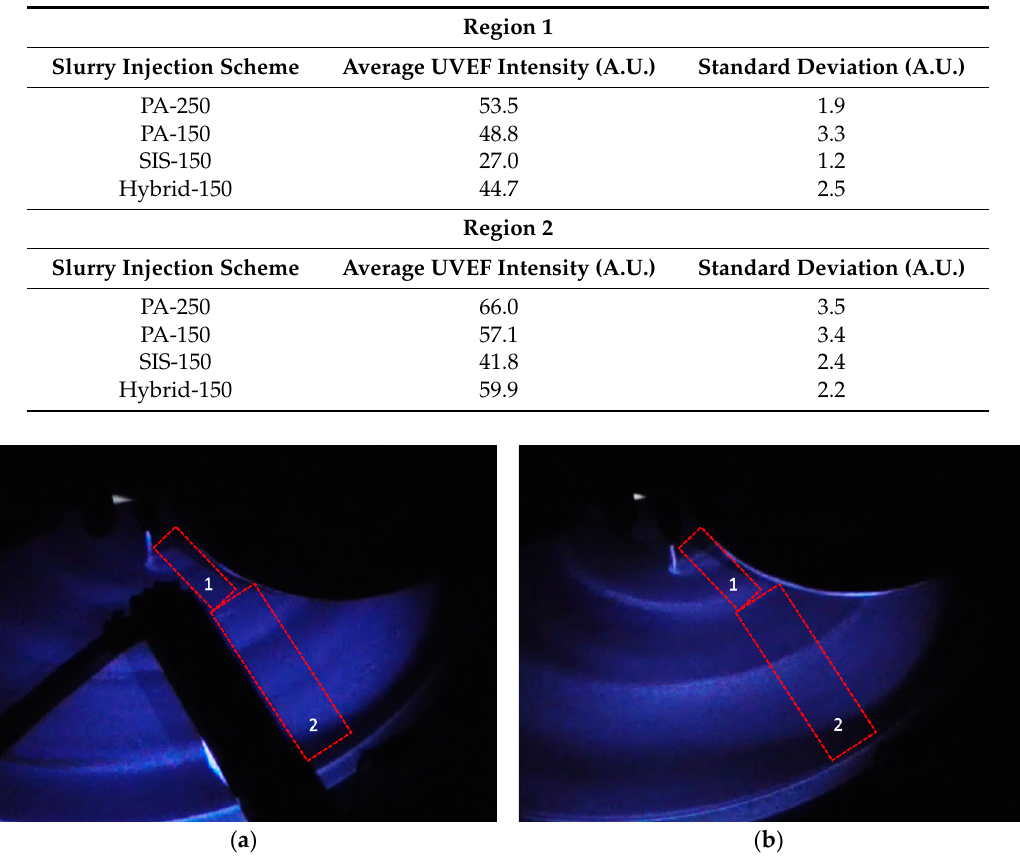
Figure 7. Regions 1 and 2 for UVEF analysis on the polishing pad: ( a ) with the SIS, and ( b ) without the SIS.